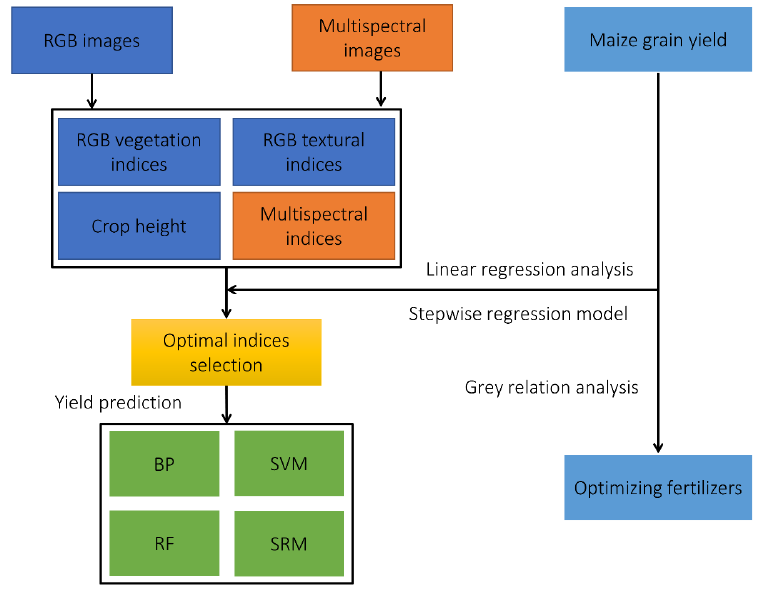
Figure 3. The workflow for predicting maize grain yield and optimizing fertilizers.